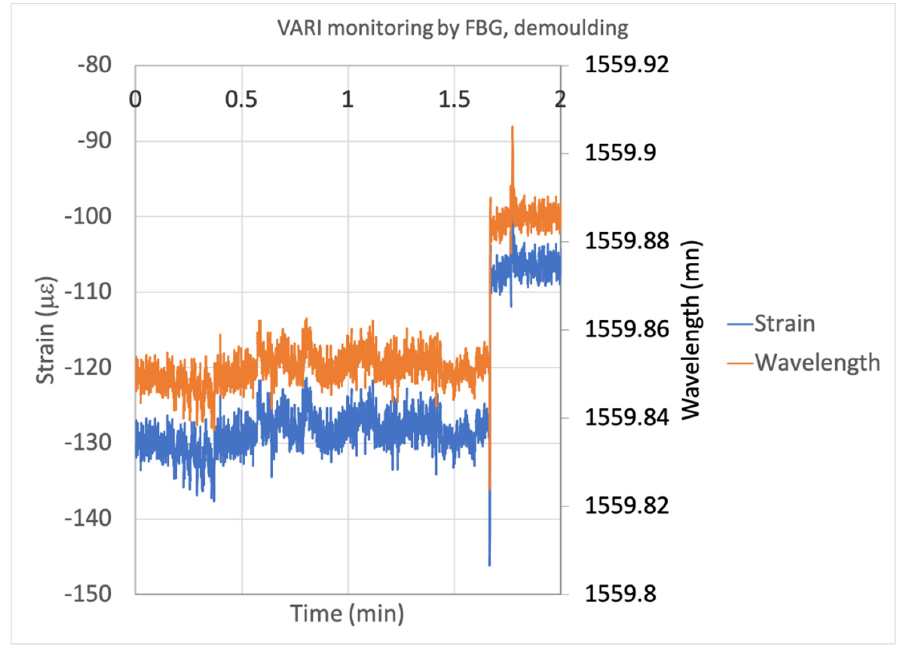
Figure 11. VARI monitoring by FBG, composite demolding with spring-back effect.